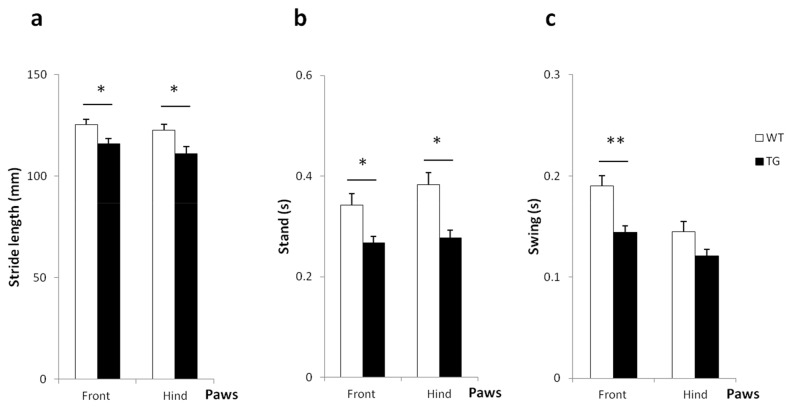
Catwalk gait analysis in 12 months old BACHD rats.Results are expressed as Mean ± SEM. There was no significant difference between TG and WT control rats in walking speed (data not shown). (a) Static parameters: Stride length. Compared to WT, TG rats had a significant shorter stride length for both front and hind paws during walking. (b-c) Dynamic parameters: presented are the Stand (c) and the Swing (d). TG rats had a significant shorter time of stand (or Stance) for front and hind paws and a shorter time in front swing than WT rats. Asterisks indicate significant differences between WT and TG rats (*p < 0.05 and **p < 0.01).